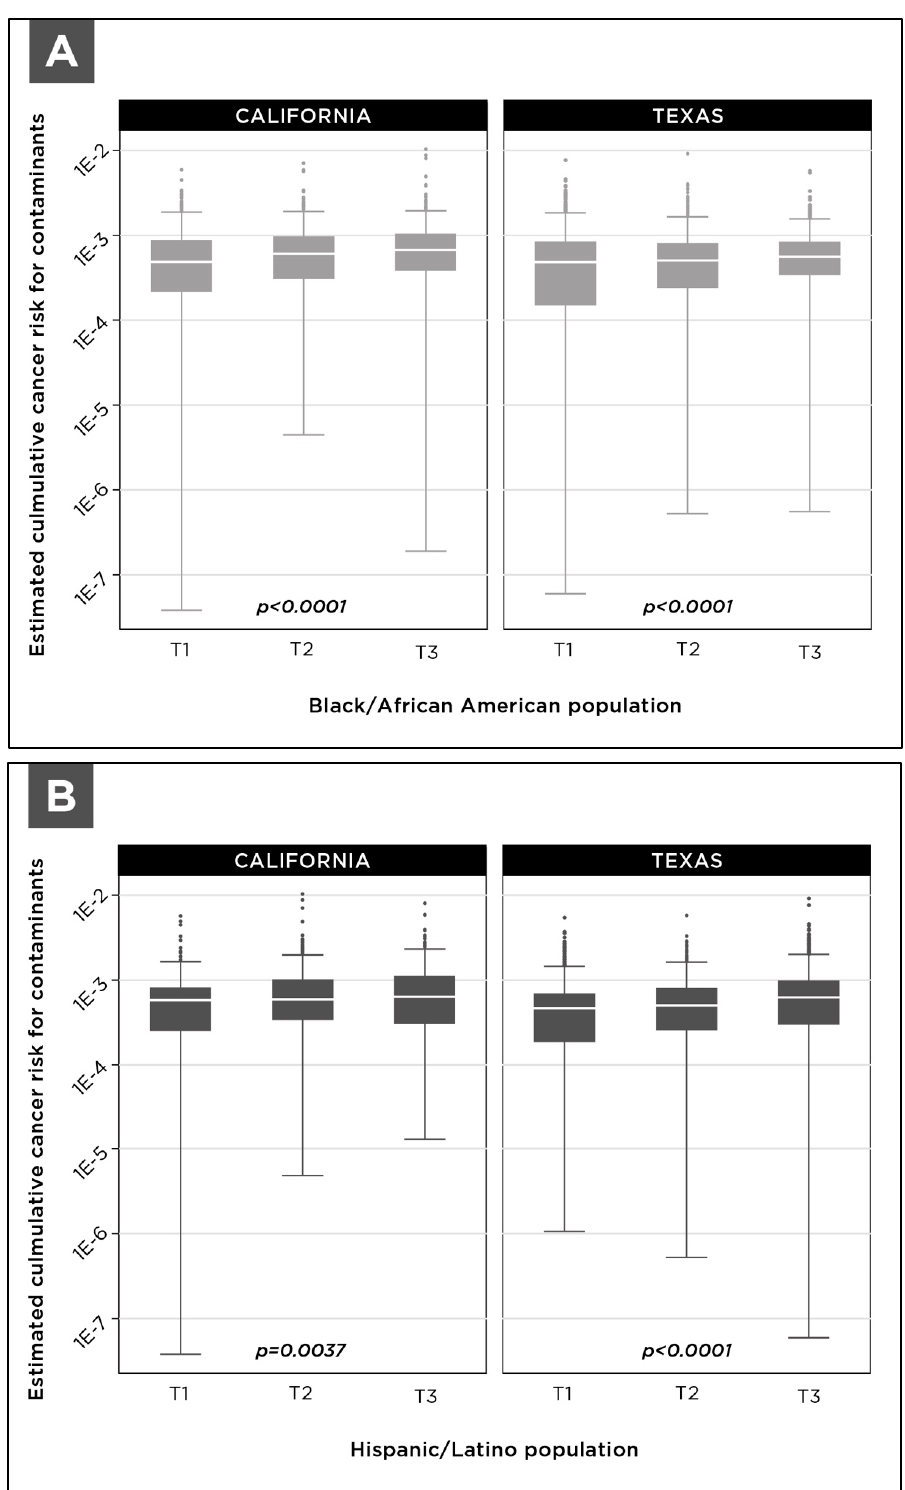
Figure 9. Cumulative cancer risk for community water systems in California and Texas grouped into terciles according to ( A ) the percentage of the population that is Black/African American and ( B ) the percentage of the population that is Hispanic/Latino within each system’s service area. Demographic percentages and total population for each tercile are listed in Appendix A, Table A3. The figure includes all systems in each state serving populations greater than 500